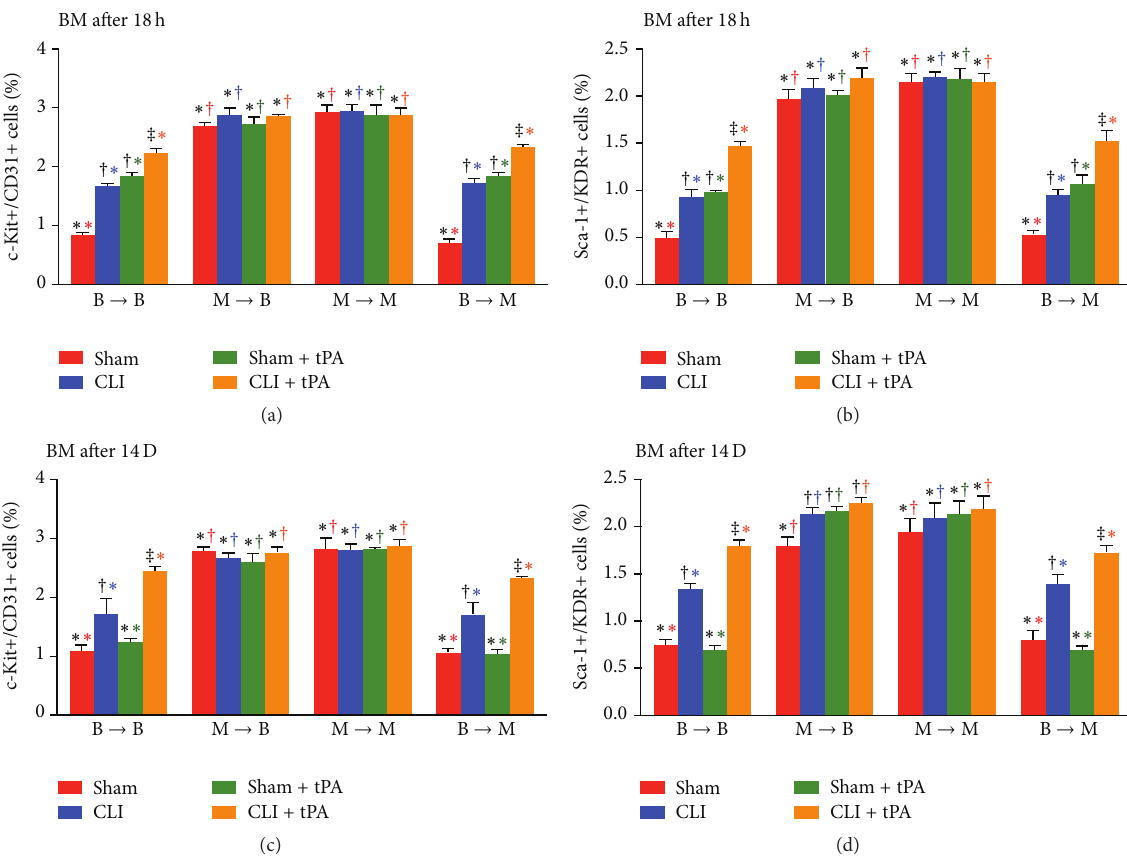
Figure 3: Flow cytometric analysis of bone marrow (BM) level of endothelial progenitor cells (EPCs) at 18h and on day 14 after critical limb ischemia (CLI) procedure. (Upper panel) Bone marrow levels of c-Kit+/CD31+ cells (a) and Sca-1+/KDR+ (b) at 18h after CLI procedure. 𝑛 = 4 for each group. (Lower panel) Bone marrow levels of c-Kit+/CD31+ cells (c) and Sca-1+/KDR+ cells (d) at day 14 after CLI procedure. 𝑛 = 6 for each group. All statistical analyses were performed by one-way ANOVA followed by Bonferroni multiple comparison post hoc test. tPA = tissue plasminogen activator. (1) Statistical analysis for subgroups [i.e., sham control (SC), CLI, SC + tPA, and CLI + tPA] of each group [group 1 (WT to WT, i.e., B → B), group 2 (MMP-9 −/− to WT, i.e., M → B), group 3 (MMP-9 −/− to MMP-9 −/− , i.e., M → M), group 4 (WT to MMP-9 −/− , i.e., B → M)]. For subgroups with different black symbols ( ∗ , † , ‡ , and §), 𝑝 < 0.05 . (2) Statistical analysis for group comparison with respective treatment condition (comparing among bar charts with the same color). (1) For SC subgroup (red bar chart), groups with different red symbols ( ∗ , † ), 𝑝 < 0.05 . (2) For CLI subgroup (blue bar chart), groups with different blue symbols ( ∗ , † ), 𝑝 < 0.05 . (3) For SC + tPA subgroup (green bar chart), groups with different green symbols ( ∗ , † ), 𝑝 < 0.05 . (4) For CLI + tPA subgroups (orange bar chart), groups with different orange symbols ( ∗ , † ), 𝑝 < 0.05